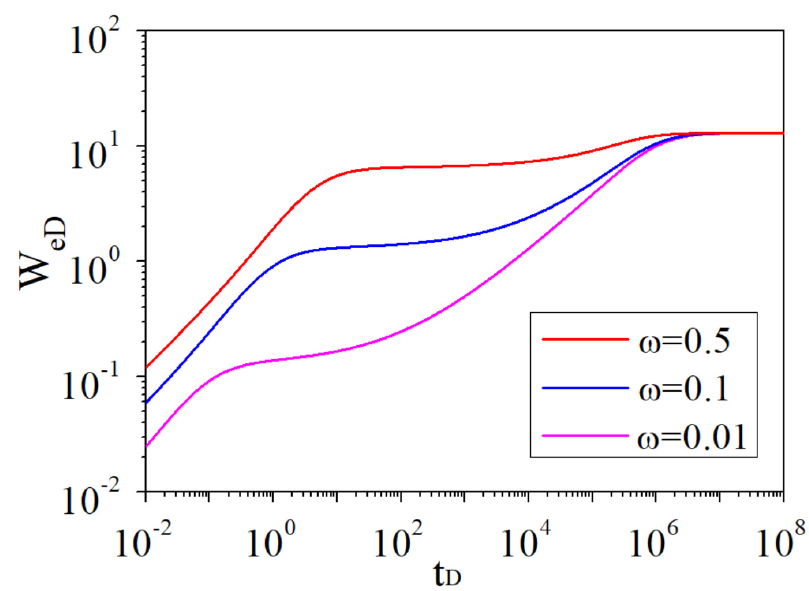
Figure 6. Dimensionless water influx curves of different ω .